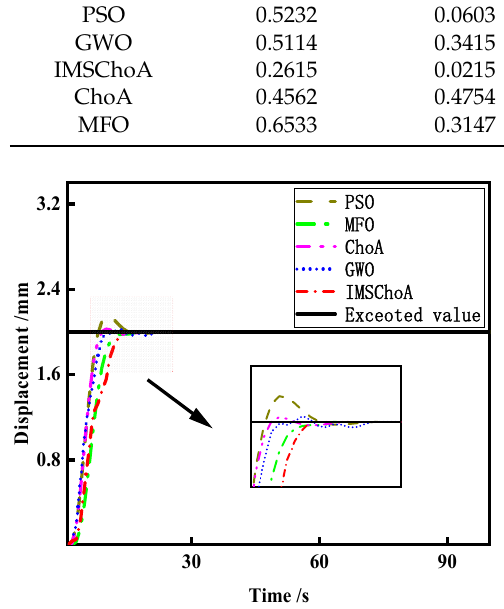
Figure 14. Displacement curve.